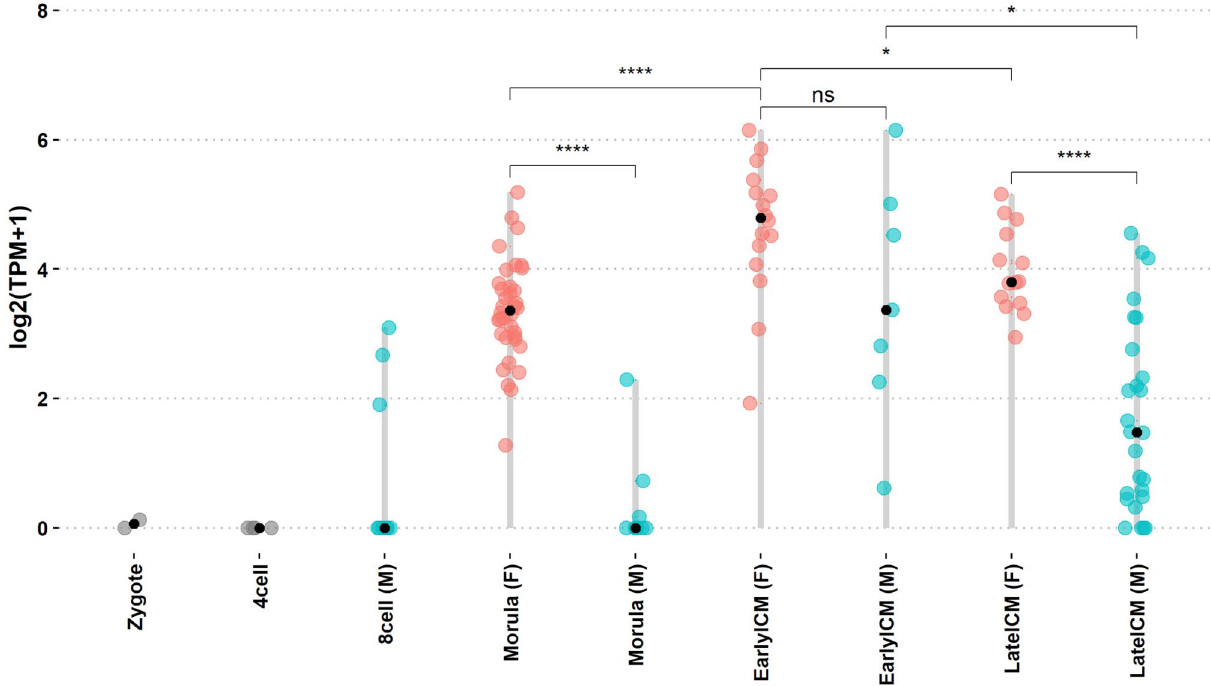
Figure 1. XIST expression in single cells during marmoset embryonic development. Each dot represents a single cell. Cells are grouped by embryonic stage and sex. Pink, female embryos (F); blue, male embryos (M). Distributions of XIST expression levels were compared using an unpaired Wilcoxon test. (*) P-value ≤ 0.05; (****) P-value ≤ 0.0001; (ns) not significant (P-value ≥